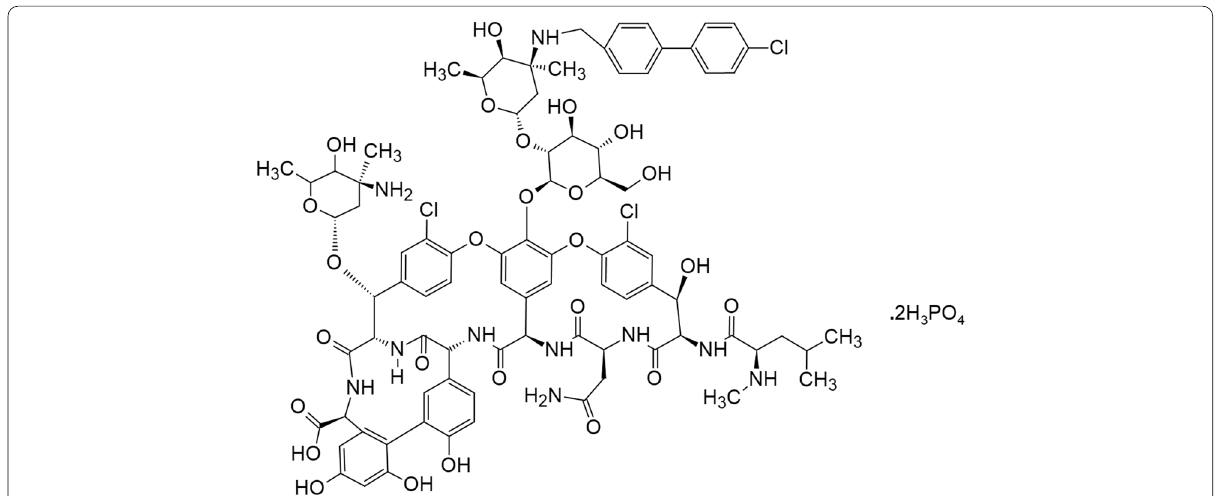
Fig. 9 Structural formula of oritavancin